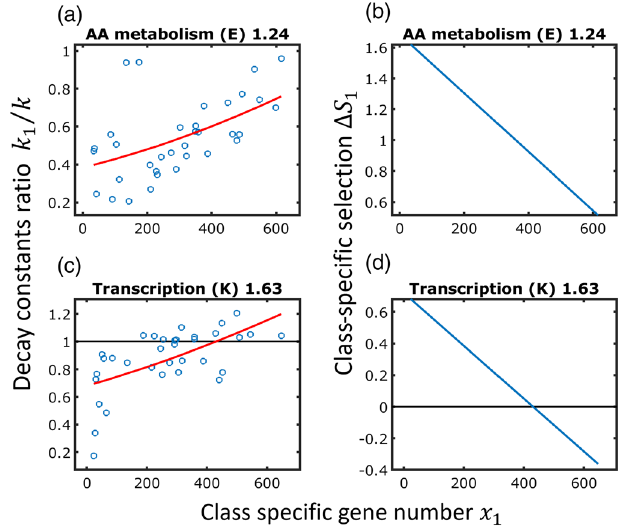
FIG. 7. Inferred selection coefficients for two functional classes of prokaryotic genes. The figure shows the comparison of two functional classes, demonstrating how different pairwise genome similarity decay rates translate into different class-specific se- lection coefficients. (a) Decay constant ratio k 1 =k is plotted against the number of genes in the functional class x 1 for amino acid metabolism genes (E). Each point corresponds to an ATGC from the dataset. The model fit is shown by the solid red line [see Fig. 3(h) for details]. (b) Inferred Δ S 1 for amino acid metabolism genes (E) resulting from the fit shown in (a). (c) Same as (a) but for transcription genes (K). (d) Same as (b) but for transcription genes